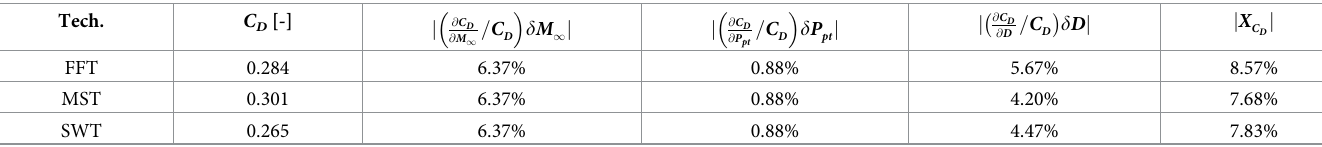
Table 2. Uncertainty analysis of the drag coefficient measurements.